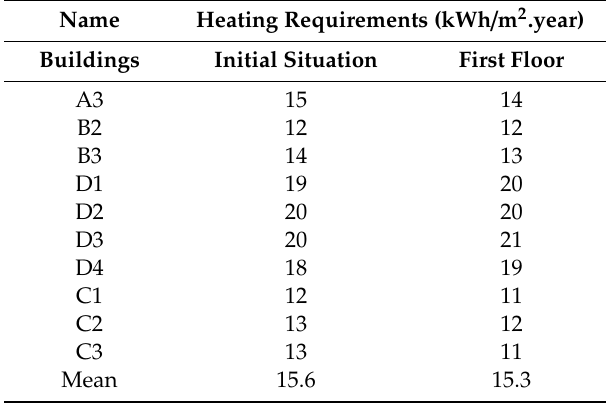
Table 9 estimates the heating requirements of the various buildings in the study area. Table 9. Heating requirements of the di ff erent neighborhood buildings in the basic and high configuration of a